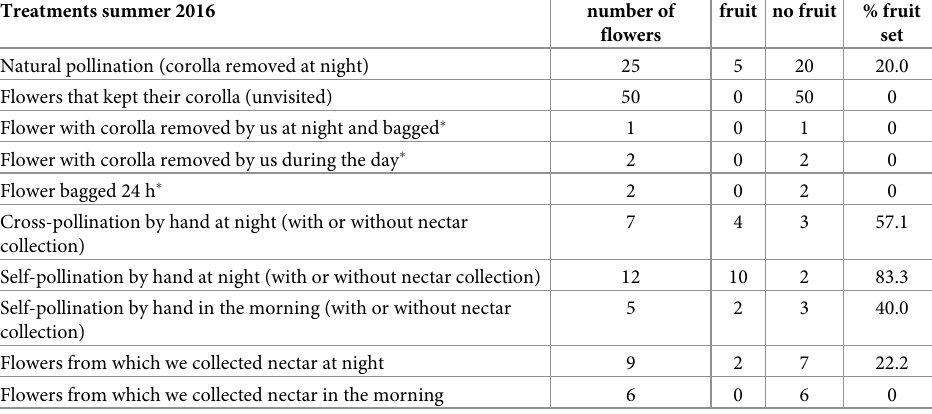
fruit no fruit % fruit flowers set 7 4 3 57.1 5 2 3 40.0